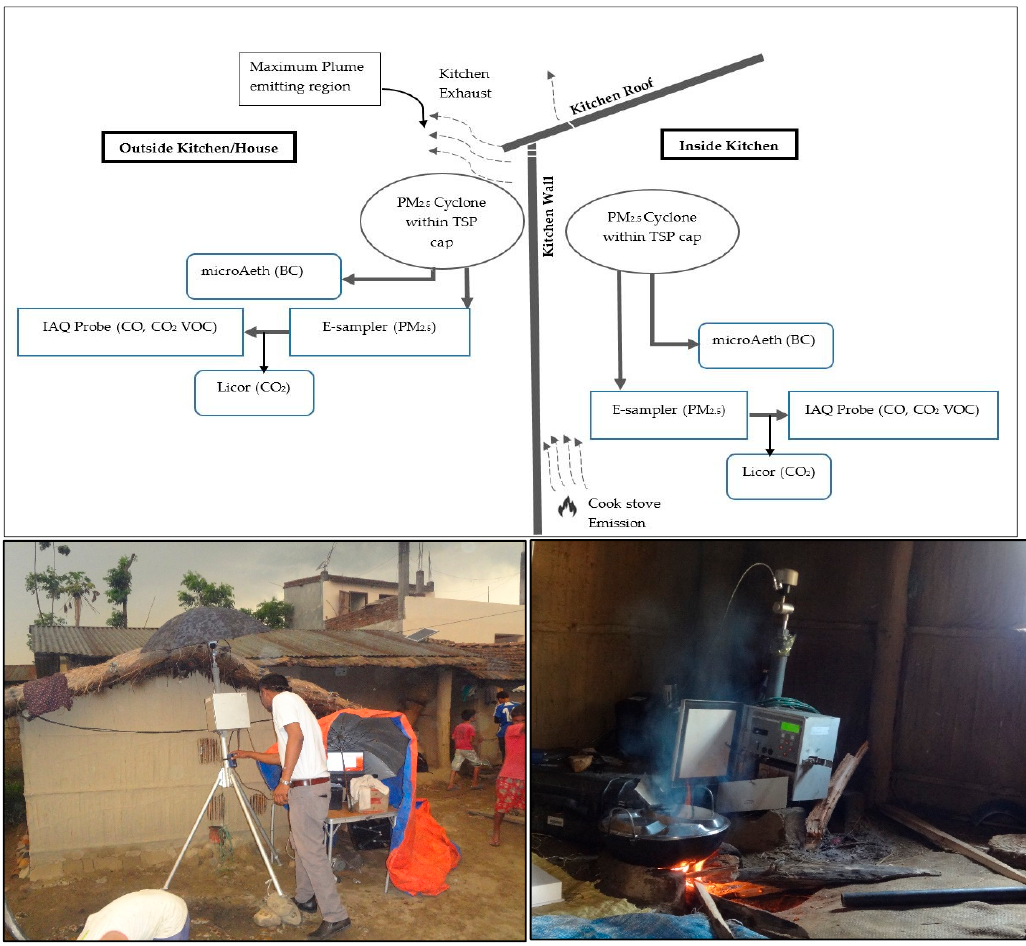
Figure 4. Top panel: schematics of the instrumental setup for cookstove emission measurement inside and outside the kitchen; Bottom right: indoor emission measurement; Bottom left: outdoor escaping emission measurement.